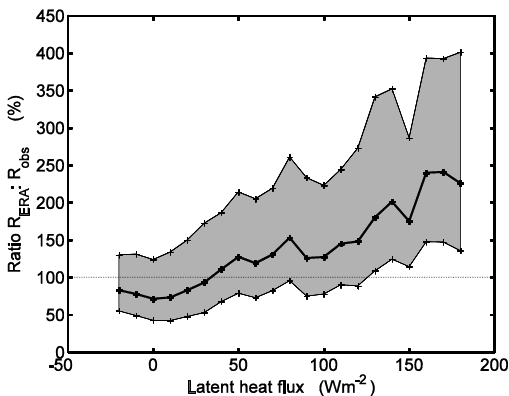
Figure 5. Ratio of ERA-Interim to observed precipitation rates as a function of latent heat fluxes, derived from ERA-Interim air pressure, air temperature, humidity, SST, and wind speed by applying the GEOMAR bulk flux scheme. The shaded area gives the standard deviation.